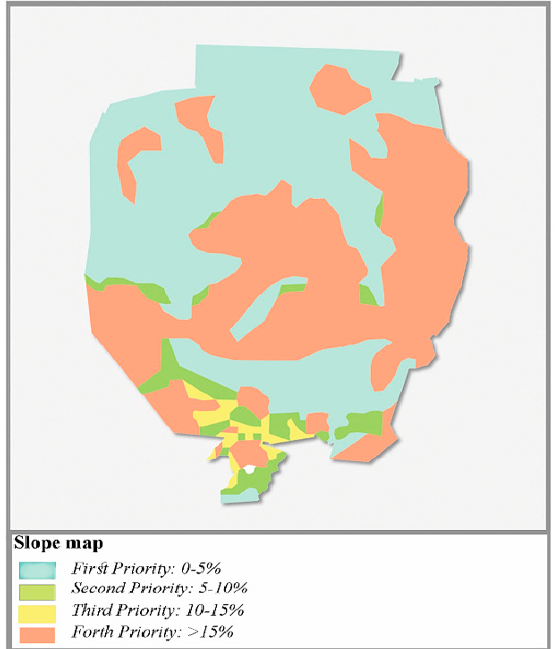
Figure 5. The slope map of Hamedan based on the sub-criteria measures in Table 1.